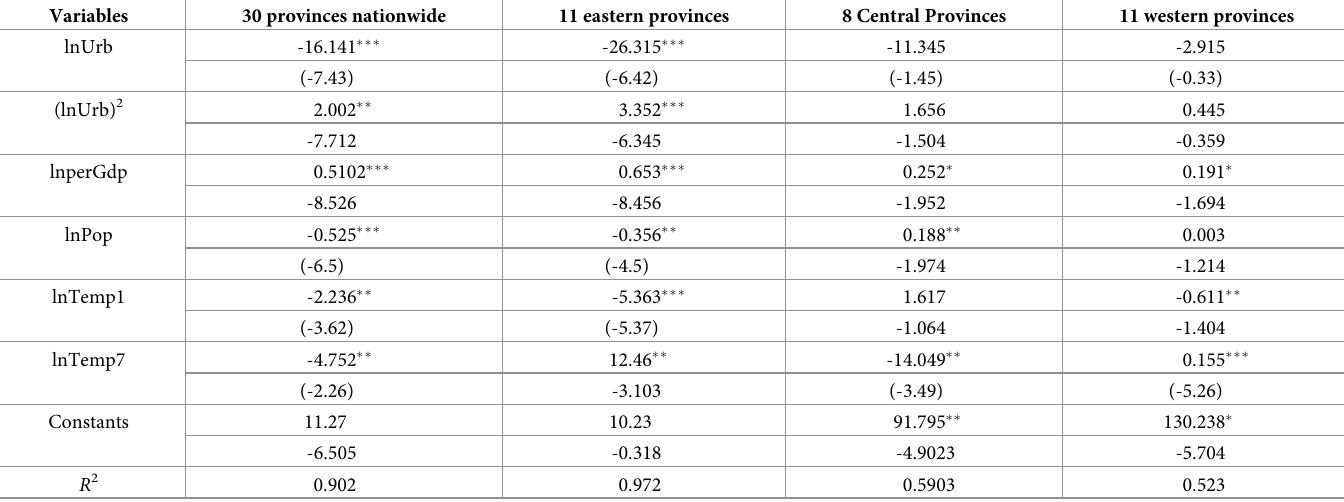
Table 7. GMM estimation results of the residential direct energy consumption model. Variables